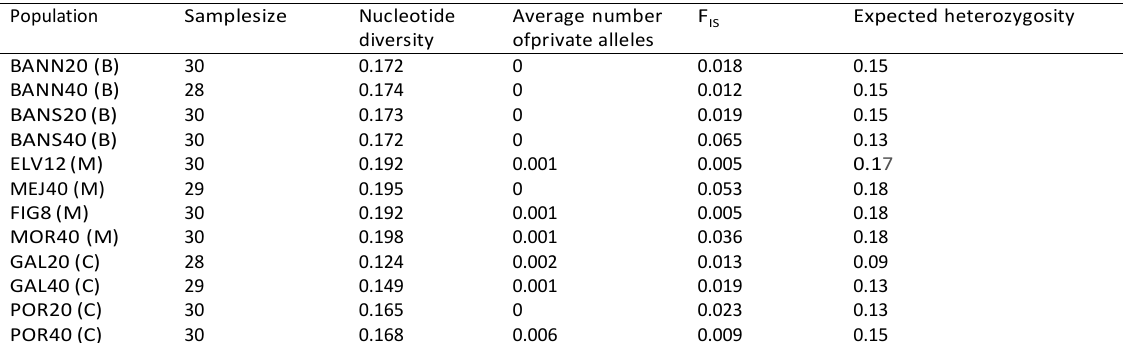
Table 4. Summary statistics of genetic diversity. The nucleotide diversities and numbers of private alleles are based on the dataset with all SNPs for each RAD-loci, excluding those with the lowest quality, and the removal of loci with minor allele frequencies below 0.01 (total 56 844 SNPs). Measures of F IS and expected heterozygosities were based on the final dataset comprising 27 461 SNPs (with one SNP / locus). The corresponding regions are indicated by a letter: M – Marseille, B – Banyuls, C – Corsica. Population Sample size Nucleotide